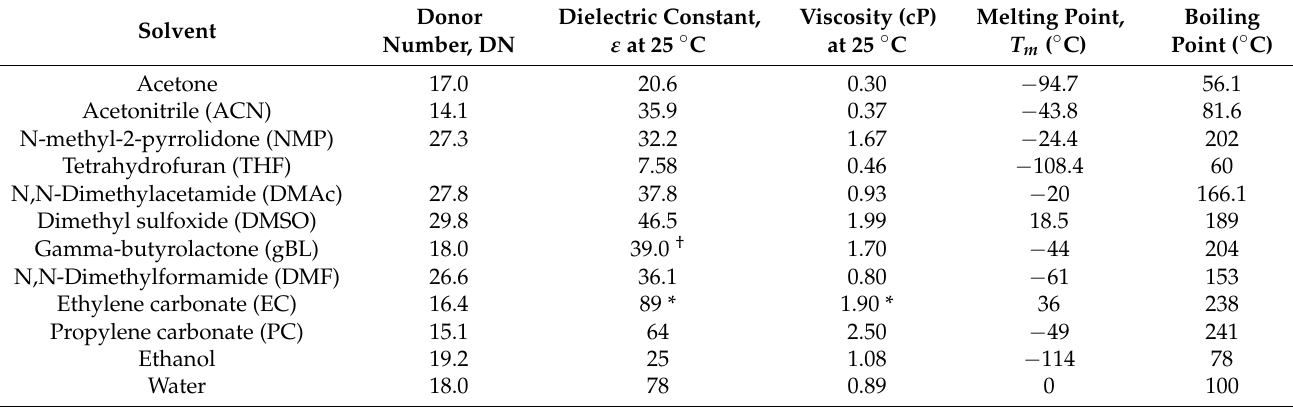
Table 3. Physical properties of some solvents